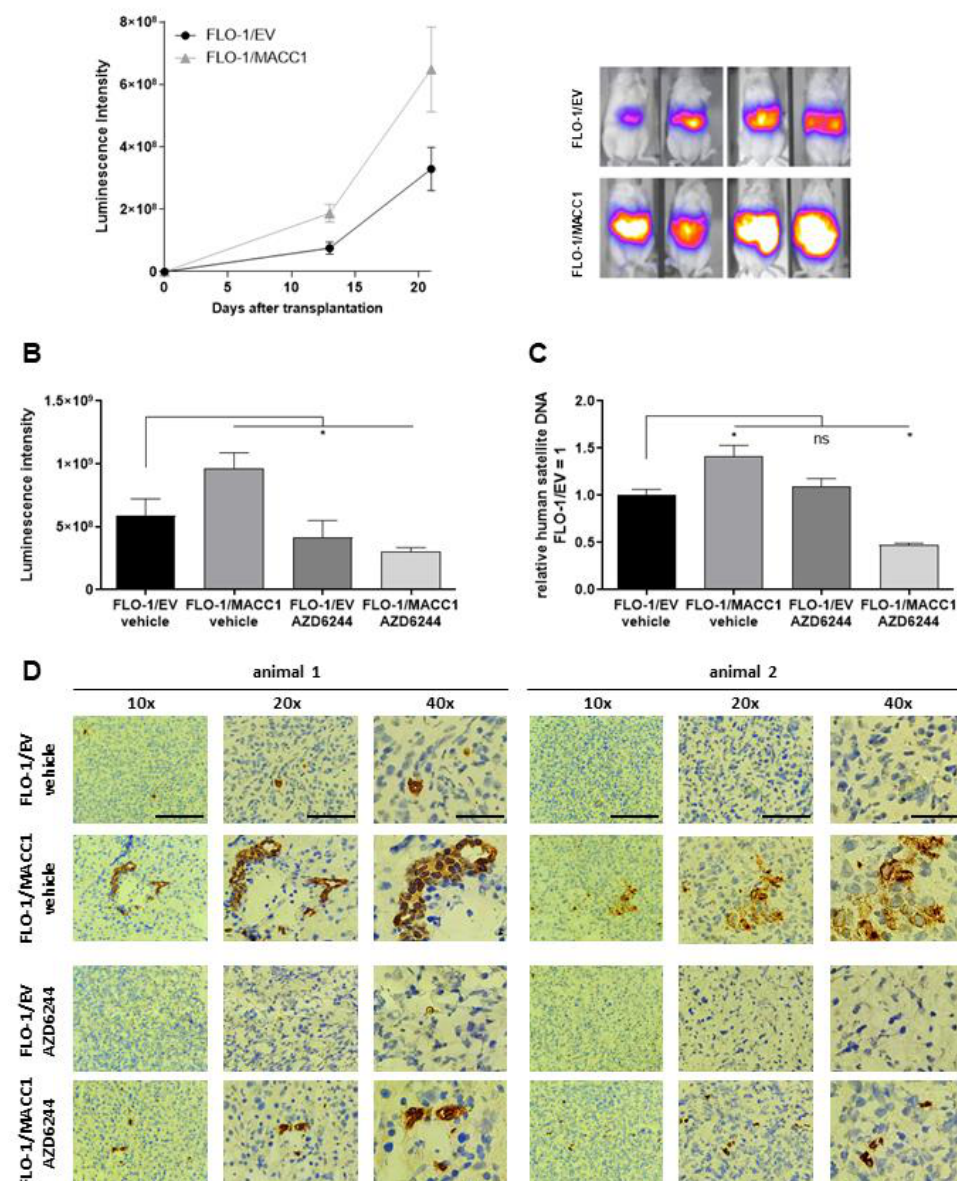
Figure 4. Effect of selumetinib (AZD6244) on MACC1-induced metastasis formation in a mouse xenograft model. ( A ) NOG mice were xenotransplanted with FLO-1/EV/Luc and FLO- 1/MACC1/Luc cells by intrasplenal injection (n = 6 per group). Metastasis formation in the liver was monitored by BLI for 21 days (left panel). Representative BLI overlays of the animals are shown in the right panel. In the next experiment, NOG mice (n = 10 per group) were xenotransplanted with FLO-1/EV/Luc and FLO-1/MACC/Luc. Mice were treated with either vehicle or AZD6244. ( B – D ) Metastasis formation in the liver was analyzed after three weeks by BLI ( B ) and human satellite DNA ( C ), and visualized by human CK19 staining of murine liver tissue ( D ). *: p < 0.05. Next, we used this model to proof for metastasis inhibition of FLO-1/MACC1/Luc- cell-transplanted tumors by selumetinib. Again, NOG animals were xenotransplanted